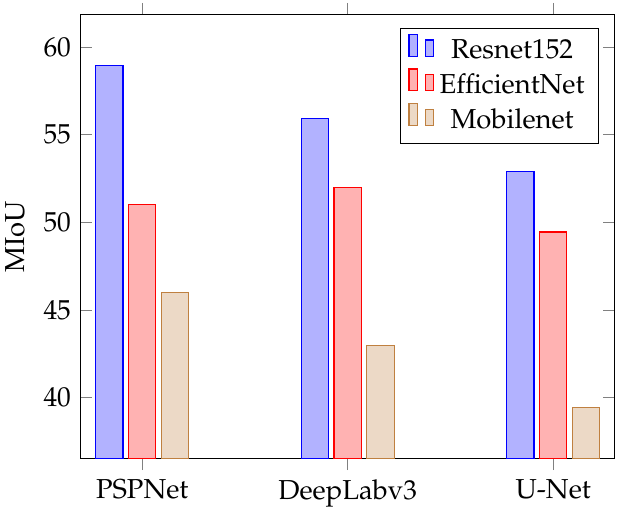
Figure 8. Accuracy (MIoU) of three neural networks and encoders used, having been trained with the pseudolabeling technique described in Section